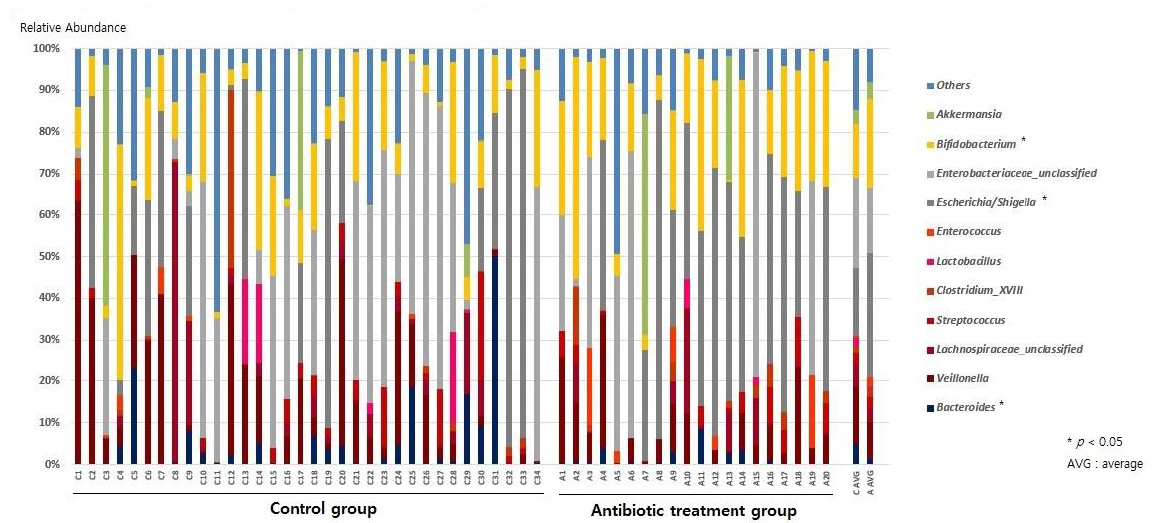
Figure 2. Gut microbiome composition at the genus